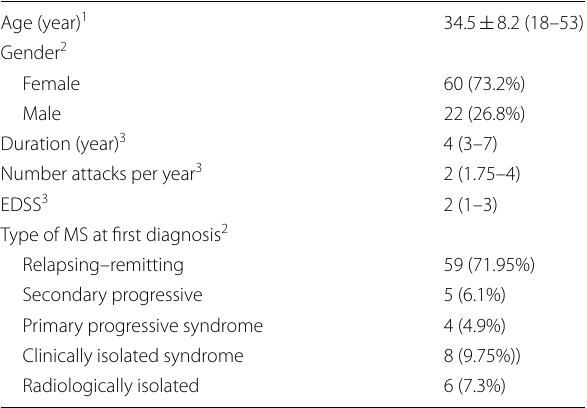
Table 1 The demographic and clinical data of MS patients